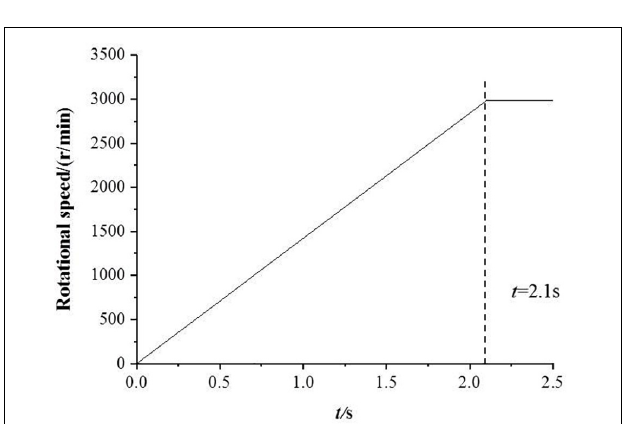
FIGURE 3 | Rotating speed change diagram of